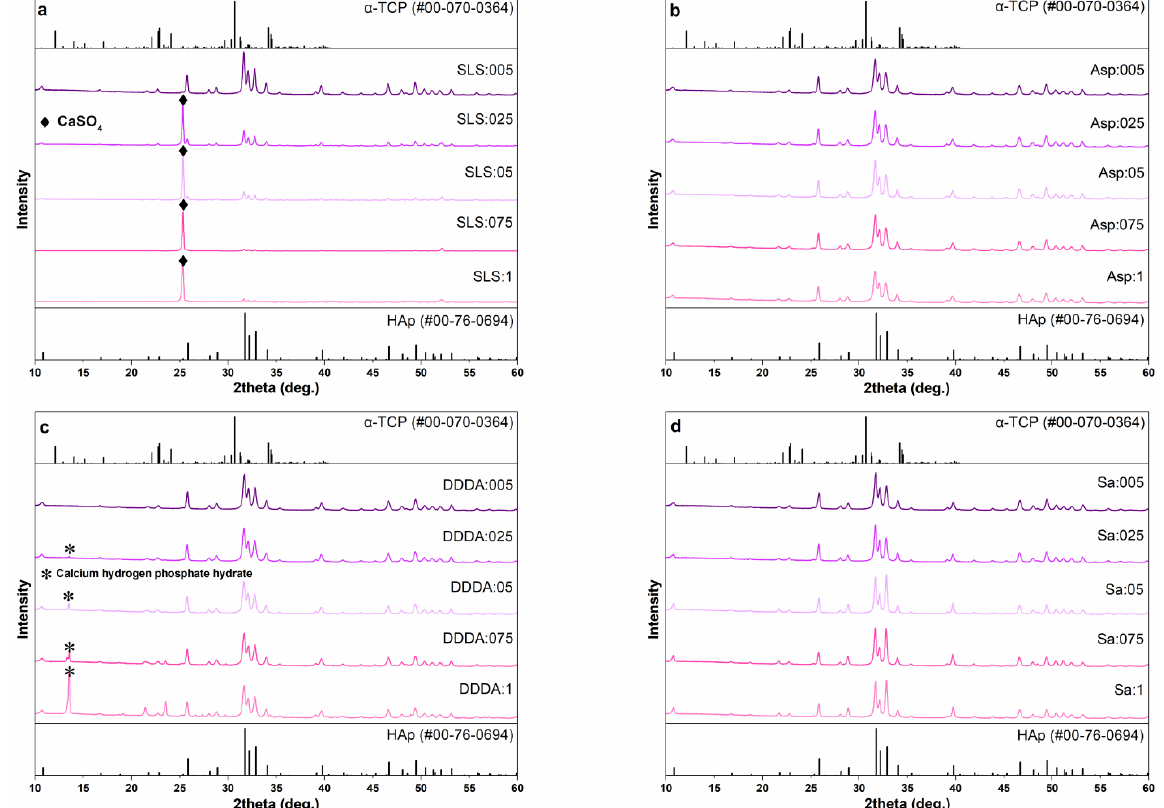
Figure 2. XRD patterns of the samples prepared using various concentrations of SLS ( a ), DL-aspartic acid ( b ), dodecanedioic acid ( c ), and suberic acid ( d ) after a hydrothermal treatment at 200 °C for 5